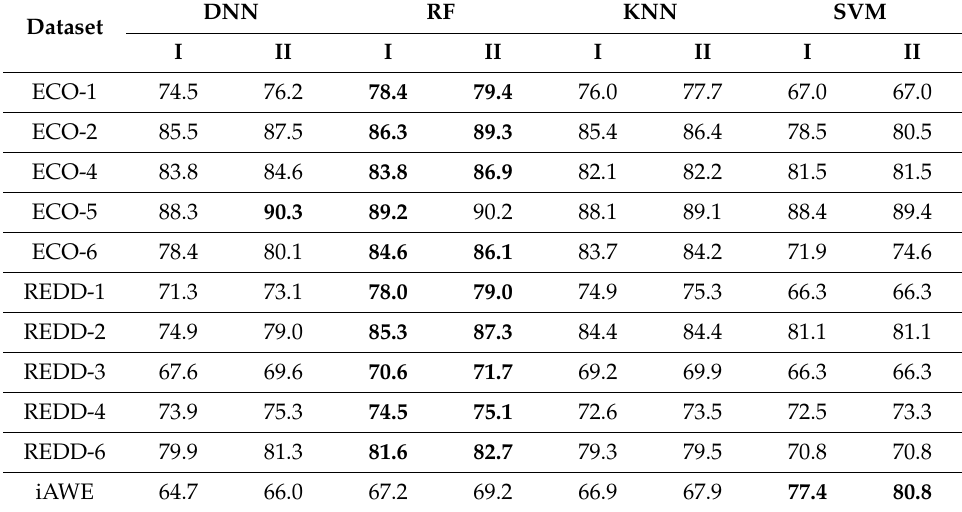
Table 3. Performance of energy disaggregation in terms of E ACC (%) for di ff erent datasets using the one-stage (I) and the proposed two-stage fusion methodology